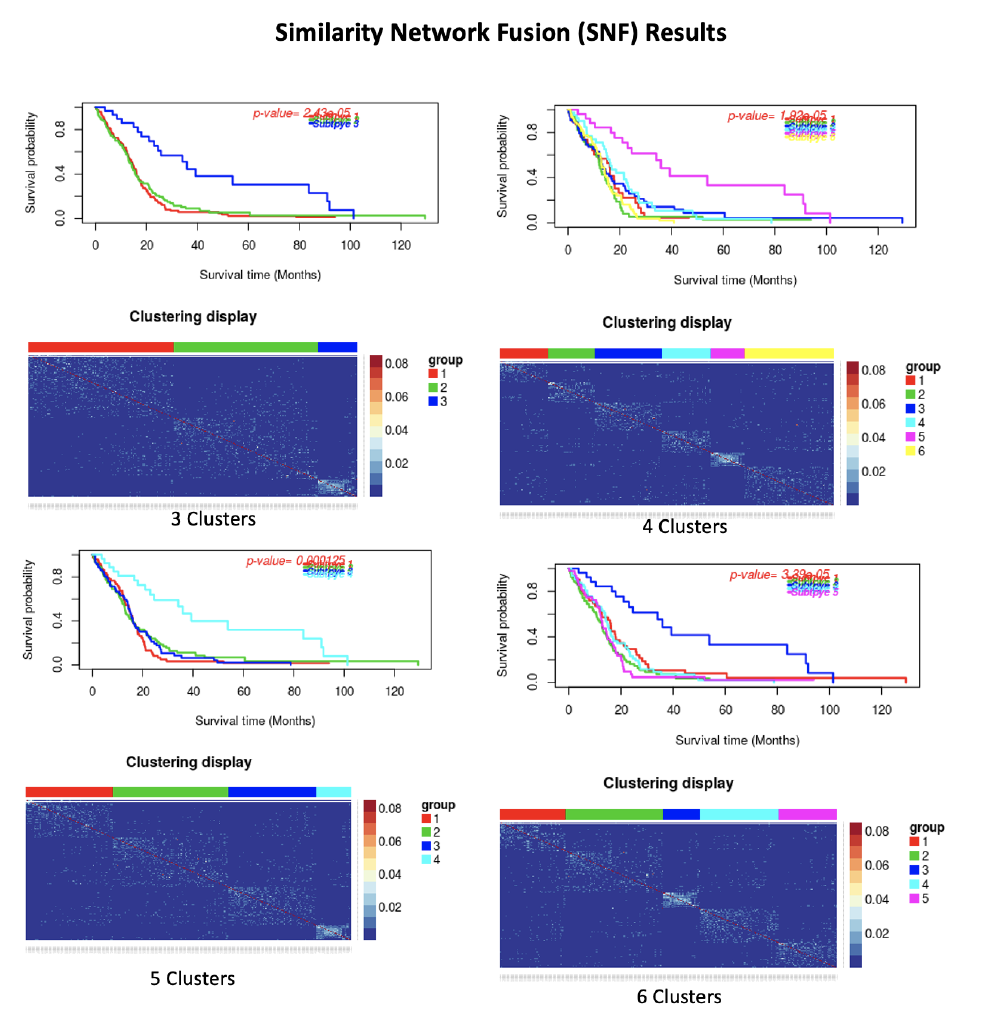
Figure 6. Similarity Network Fusion (SNF) results. In each subfigure, ( Top ): Kaplan-Meier sur- vival curves of the identified clusters. ( Down ): Patient to patient similarity and identified clusters on the